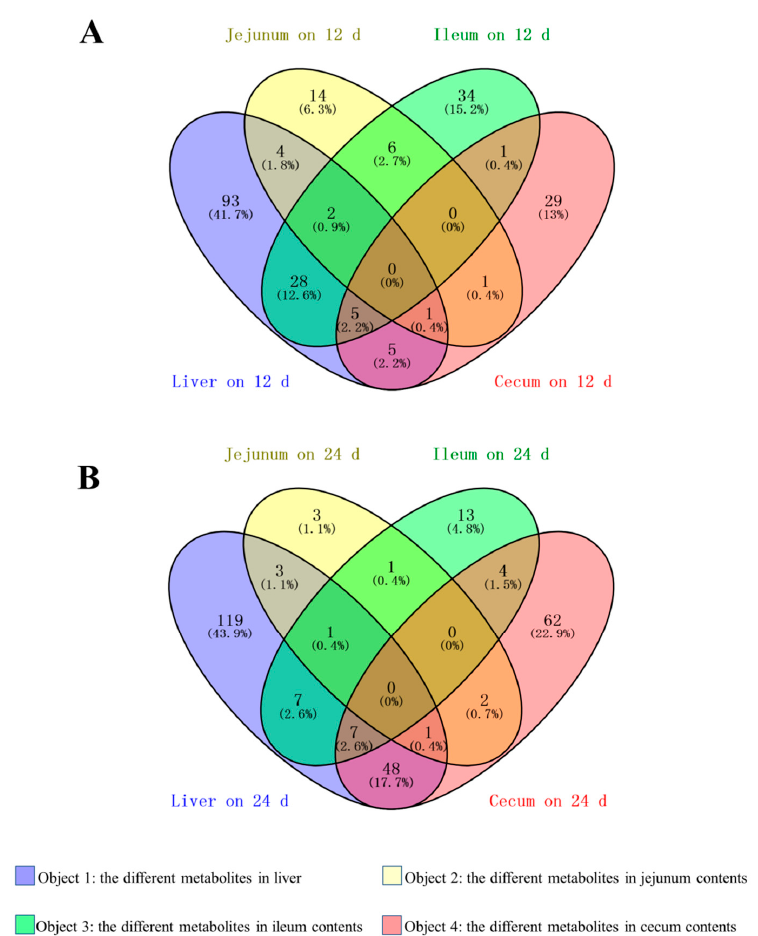
Figure 3. Venn diagram of differential metabolites in the liver, jejunal, ileal, and cecal contents of the overfed vs. control geese on day 12 (( A ), 12 d) and day 24 (( B ), 24 d) of overfeeding.